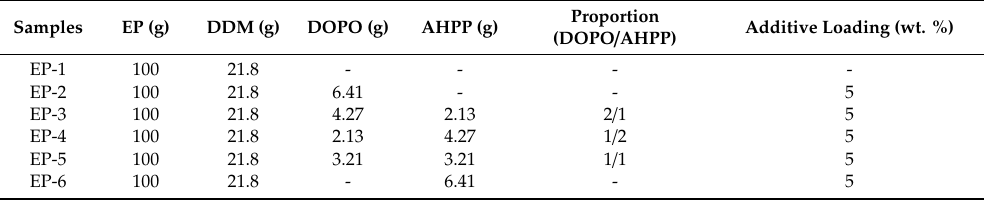
Table 1. The formulations of pristine epoxy resin (EP) and its